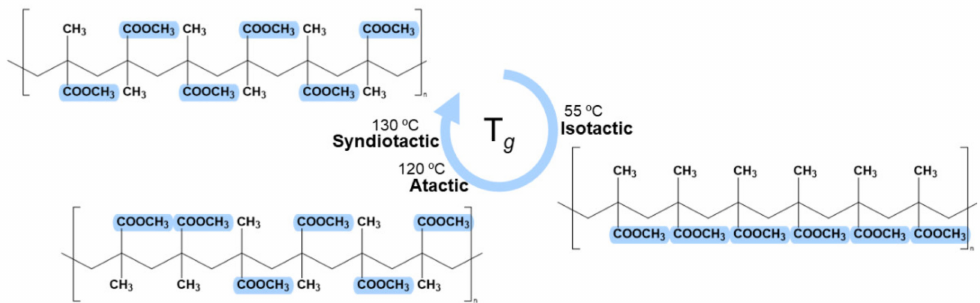
Figure 4. PMMA tacticities: isotactic, syndiotactic, and atactic and respective glass transition temperature. The tacticities values were collected from